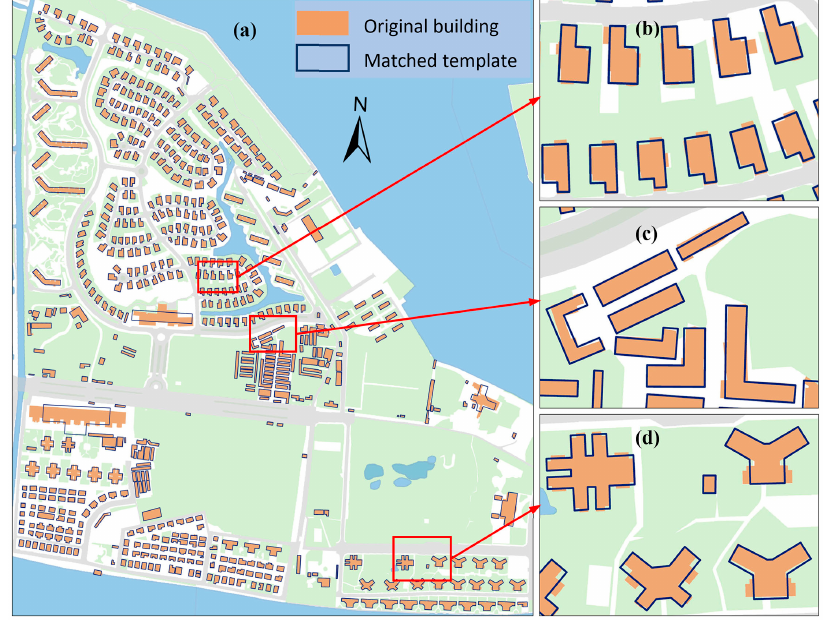
Figure 6. The result of building simplification: ( a ) the comparison of buildings before and after simplification using template matching; ( b – d ) showing the local details.